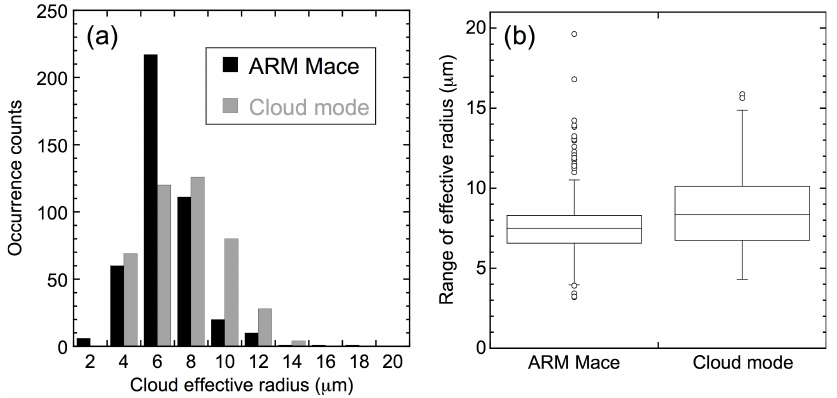
Fig. 9. Intercomparison of cloud effective radius retrieved from cloud mode to those from the ARM Mace dataset by showing (a) the histograms of the occurrence counts, and (b) the box plots. Note that cloud-mode retrievals represent a 1.5-min average droplet radius, while the ARM Mace retrievals represent a 5-min average radius.